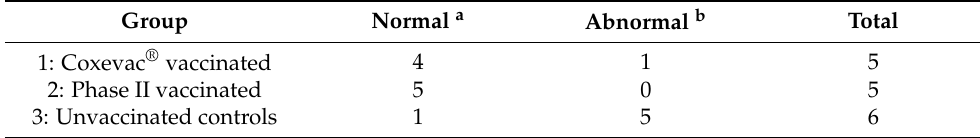
Table 7. Number of normal or abnormal pregnancies. Group Normal a Abnormal